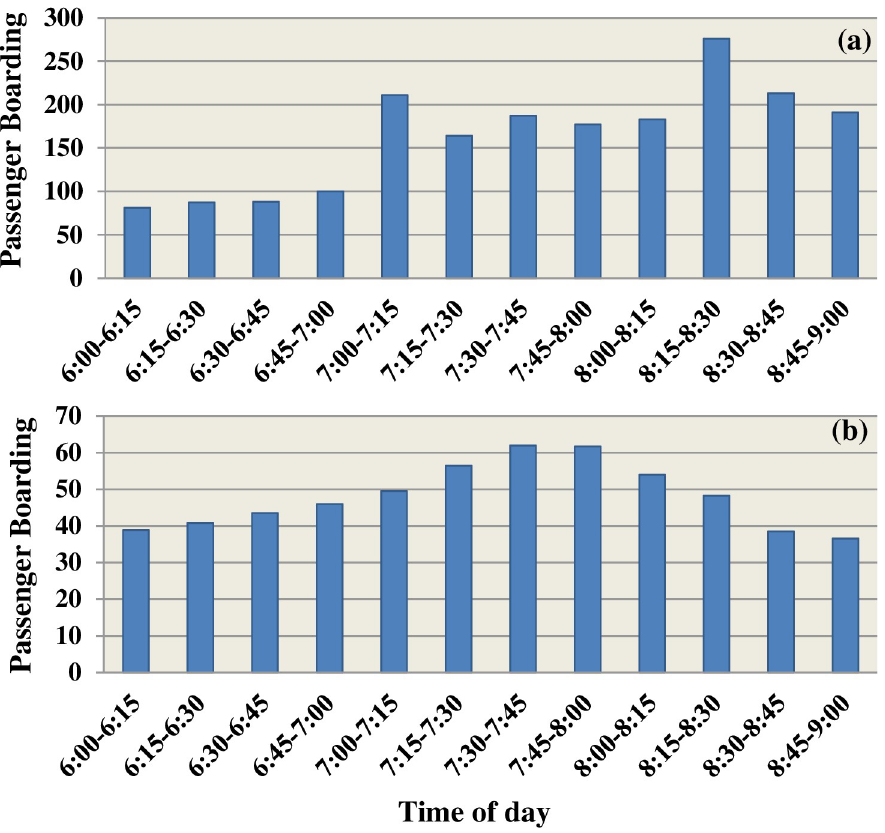
Fig 4. Mean of passenger boarding per 15-minute time interval, a) AM peak, out-bound; b) AM peak, in-bound.